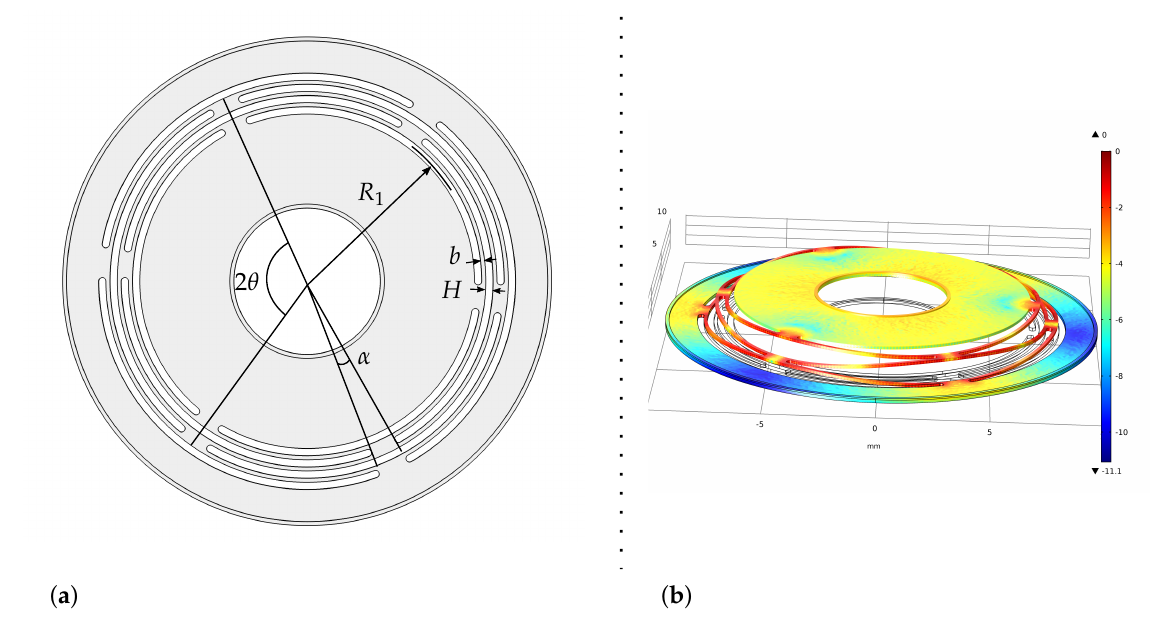
Figure A1. ( a ) Top view of one ortho-planar spring and parametrization. H is the spacing between the beams, b is the width of the beams in the radial direction. α is the aperture angle of the material remaining between two cuts and θ is half of the aperture angle of the cuts; ( b ) Normalized stress log ( σ / max ( σ )) . A total force of 1 N was applied to the interior border. The maximal stress is located at the ends of the curved